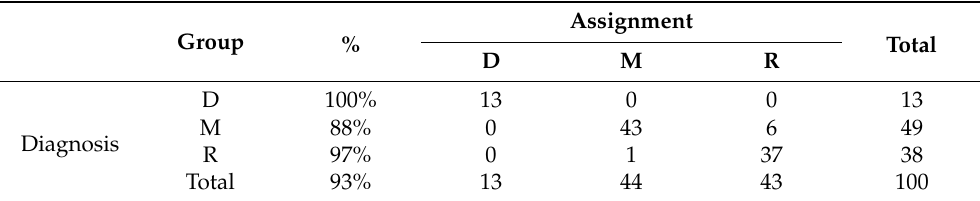
Table 2. Obtained classification matrix for matching fibres by multivariate discriminate analysis for 70% of randomly selected fibres. Abbreviations: D—dystrophies group; M—myopathy group; R—reference group.